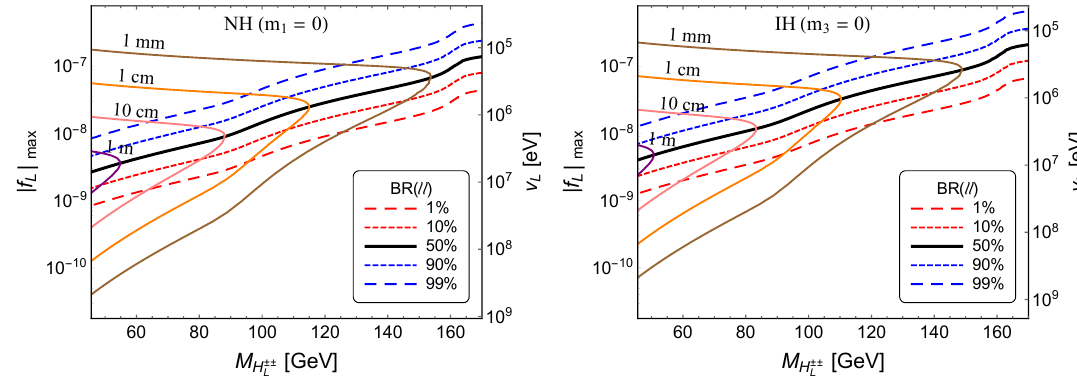
Figure 1 . Contours of proper decay length c(cid:28) 0 of 1 mm, 1 cm, 10 cm and 1 m of the LH doubly- charged scalar H (cid:6)(cid:6) in type-II seesaw, as functions of the doubly-charged scalar mass M L the largest Yukawa coupling j ( f L ) max j . Also shown are the BR( H (cid:6)(cid:6) W (cid:6) ( (cid:3) ) W (cid:6) ( (cid:3) ) ) = 1%, 10%, 50%, 90%, 99%. The left and right panels are respectively for the neutrino spectra of NH and IH with zero lightest neutrino mass. The corresponding values of the VEV v L are also shown in the